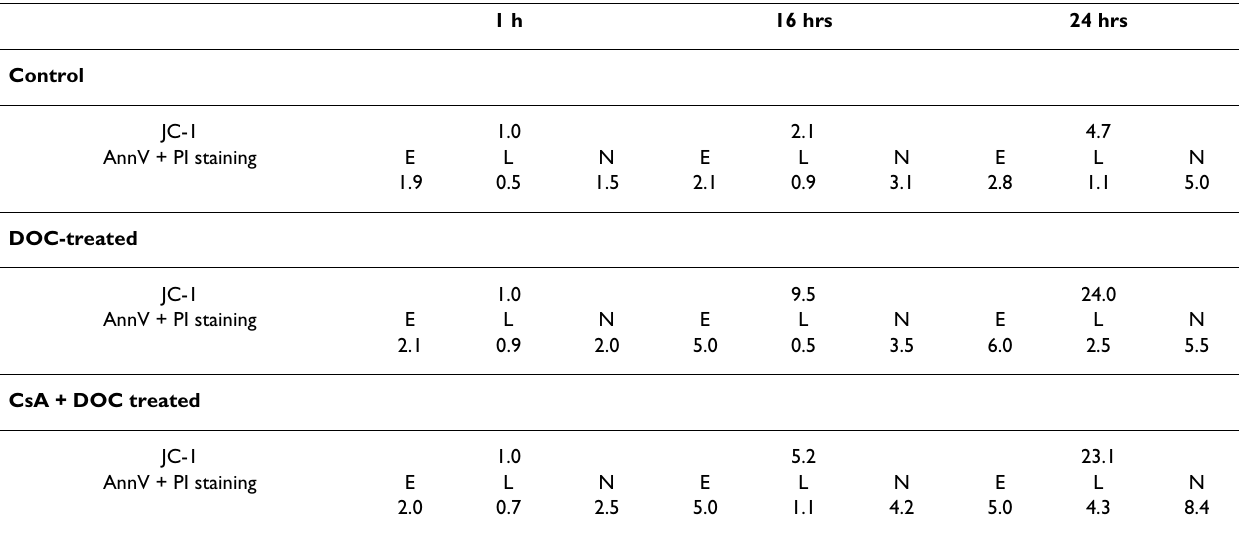
Table 3: Effect of pre-incubation with CsA on DOC-treated HT 1376